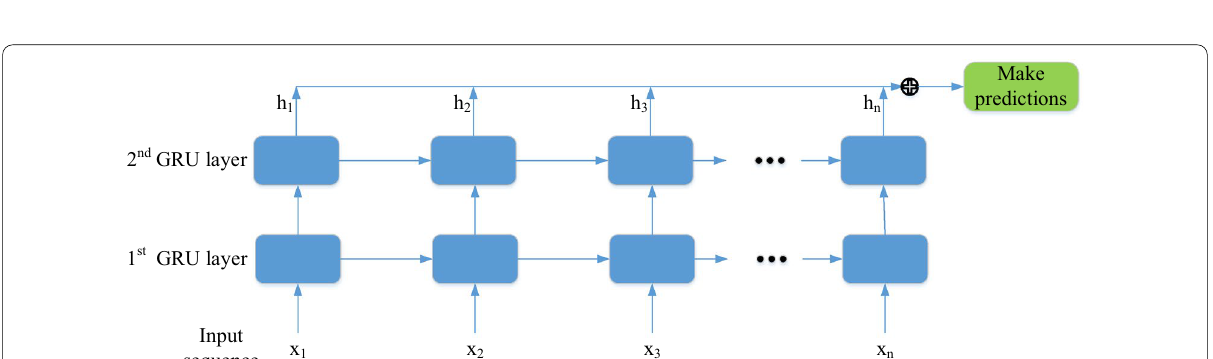
Figure 6 One-layer GRU